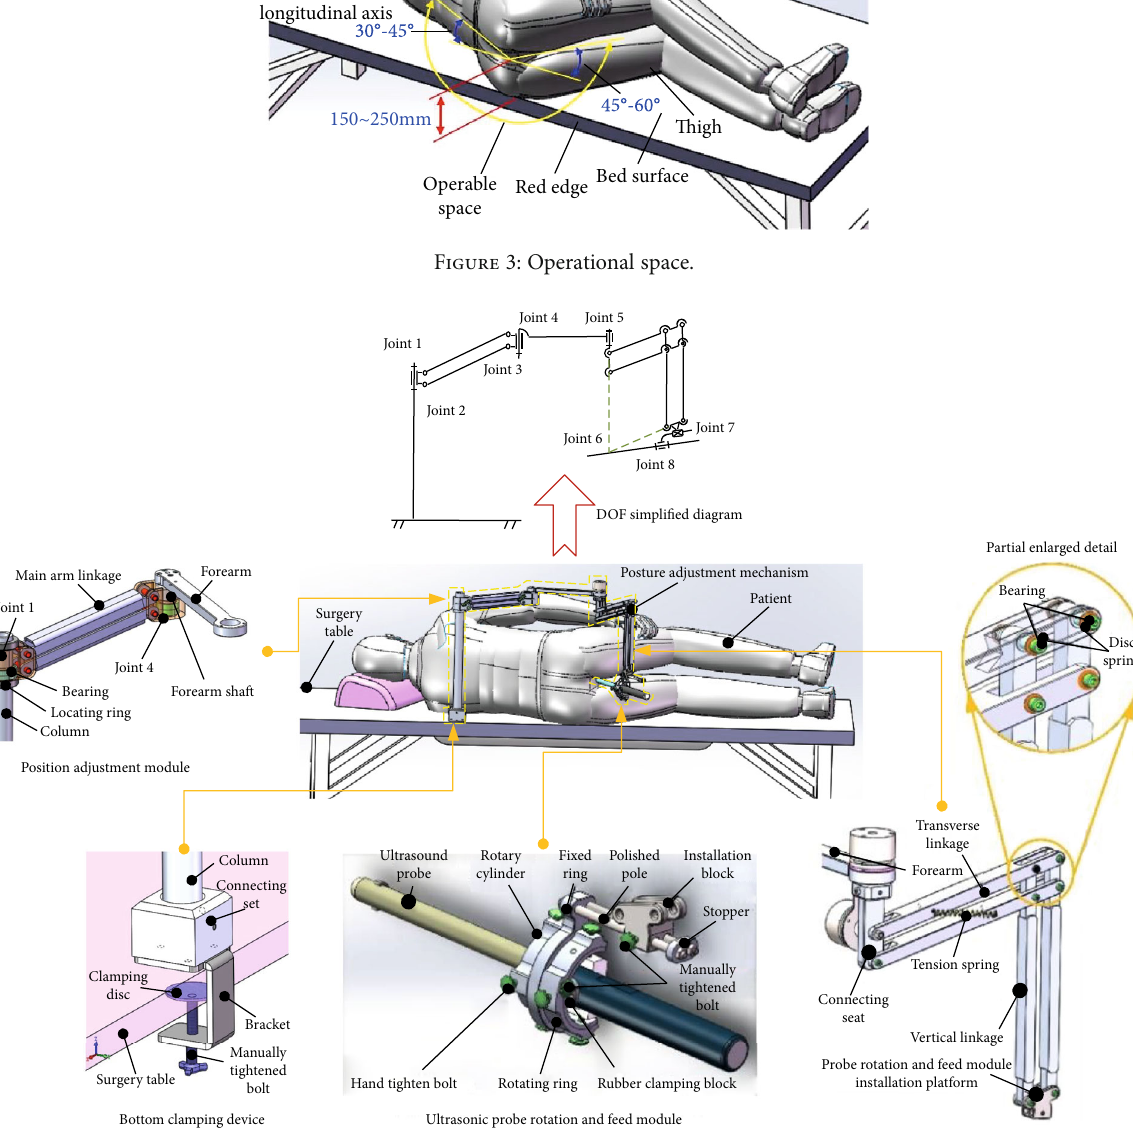
Figure 4: Schematic diagram of the position adjustment mechanism of the transrectal ultrasound probe and each module structure